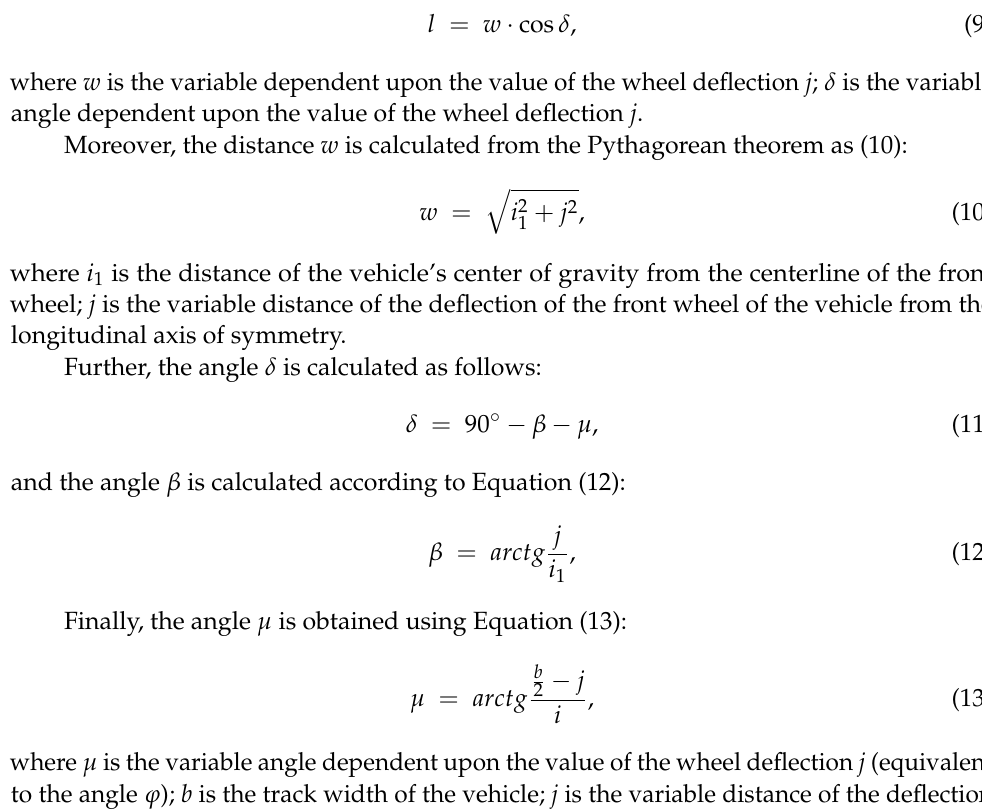
Figure 11. Position of the center of gravity: ( a ) The E3-cycle; ( b ) E3-cycle along with the model rider. The way the E3-cycle passes through the curve affects its stability condition